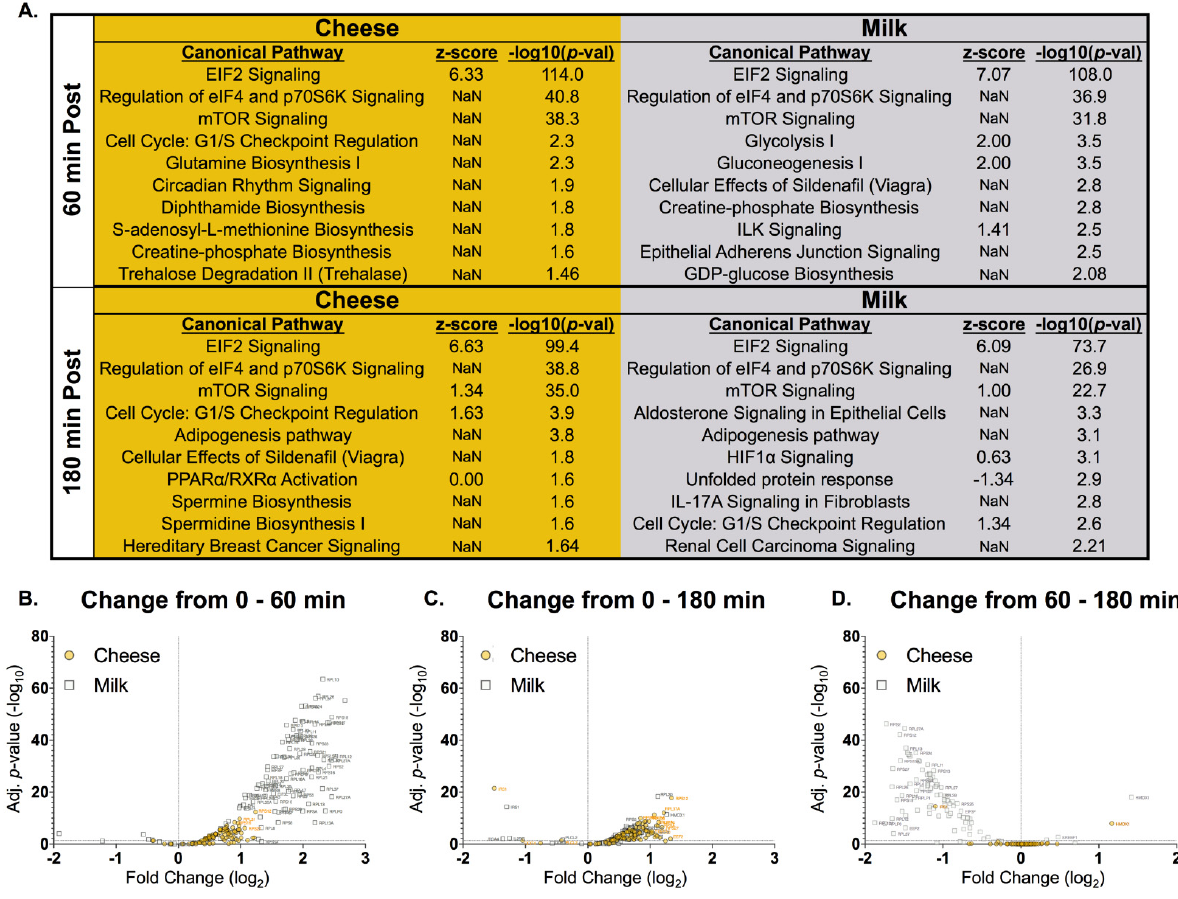
Figure 6. Skeletal muscle analysis of translated mRNAs assessed using ribosomal sequencing before and after cheese or milk ingestion in men and women ( n = 4; 2 M, 2 F). ( A ) Canonical pathways identified by ingenuity pathway analysis for cheese and milk at 60 and 180 min and ( B ) Volcano plot of the change in translated mRNAs for cheese (orange squares) or milk (gray squares) from 0 to 60 min, ( C ) 0 to 180 min, and ( D ) 60 to 180 min post ingestion.